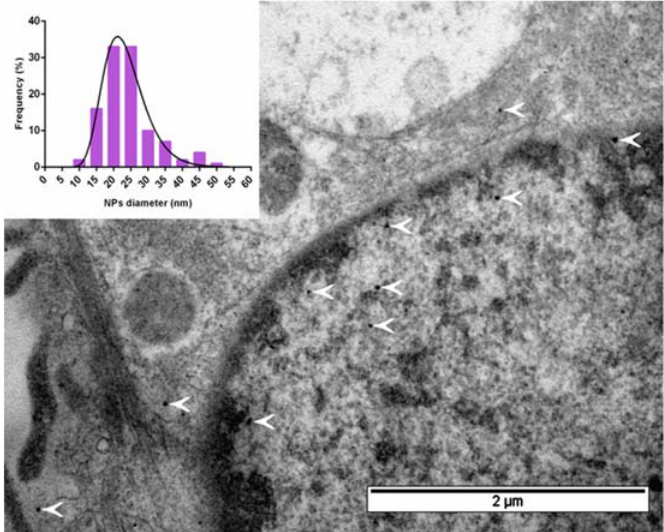
Figure 5. Bright-field TEM image of an ultrathin section of hAD-MSCs-Mx cells after 24 h of incubation with 2 mM FAS; white arrows indicate iron oxide deposits inside encapsulin nanocompartments. The inset illustrates the size distribution of iron oxide cores inside the encapsulin shell. Scale bar 2 µm.